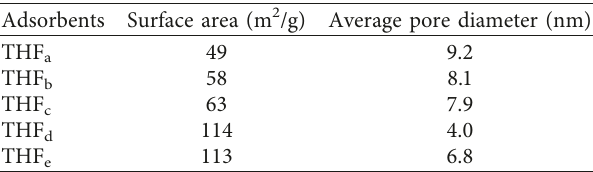
Table 5: BET analysis of hollow-fiber adsorbents with different compositions.